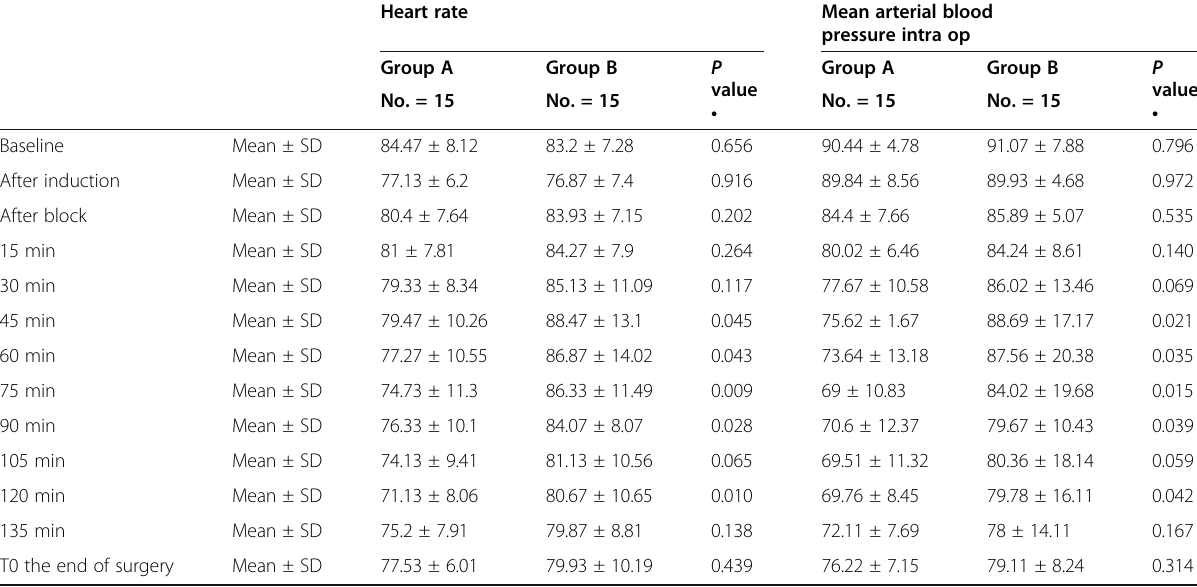
Table 2 Comparison between group A and group B regarding heart rate and mean arterial blood pressure at different times of measurement